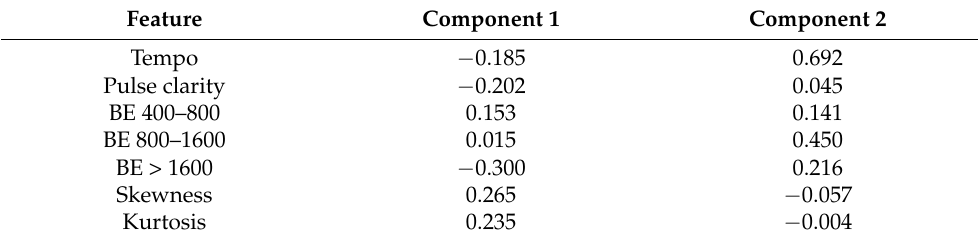
Figure 6. The scree plot of Principal Component Analysis (PCA). Table 4. The coefficient matrix of